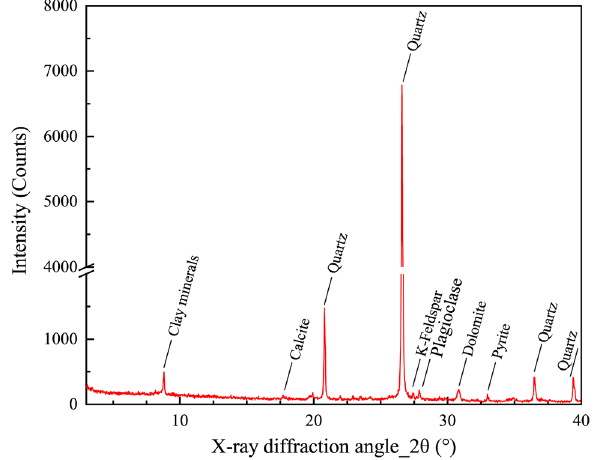
Fig. 4 XRD (X-ray diffraction pattern) result of